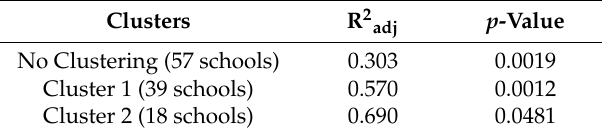
Table 2. R 2 adj and p -value calculated for each cluster and for the sample without clustering.